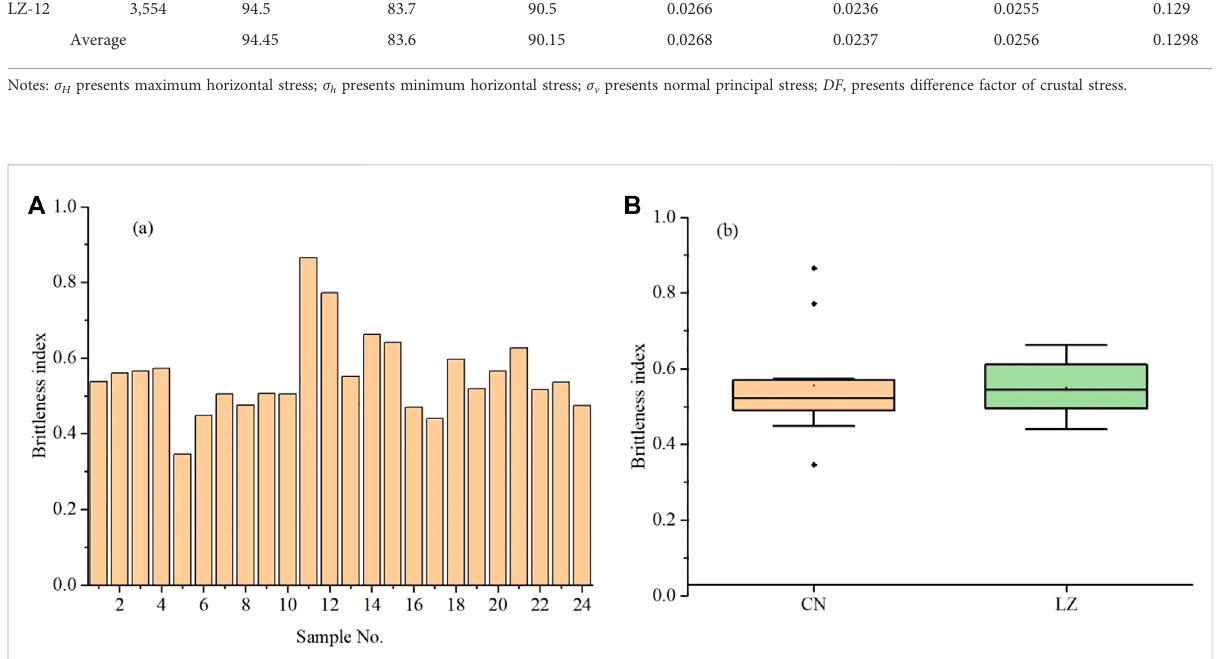
FIGURE 8 Distribution of the brittleness index of the Longmaxi Formation shale in the study area. Notes: (A) Brittleness index distribution for different samples; (B) Distribution range of brittleness